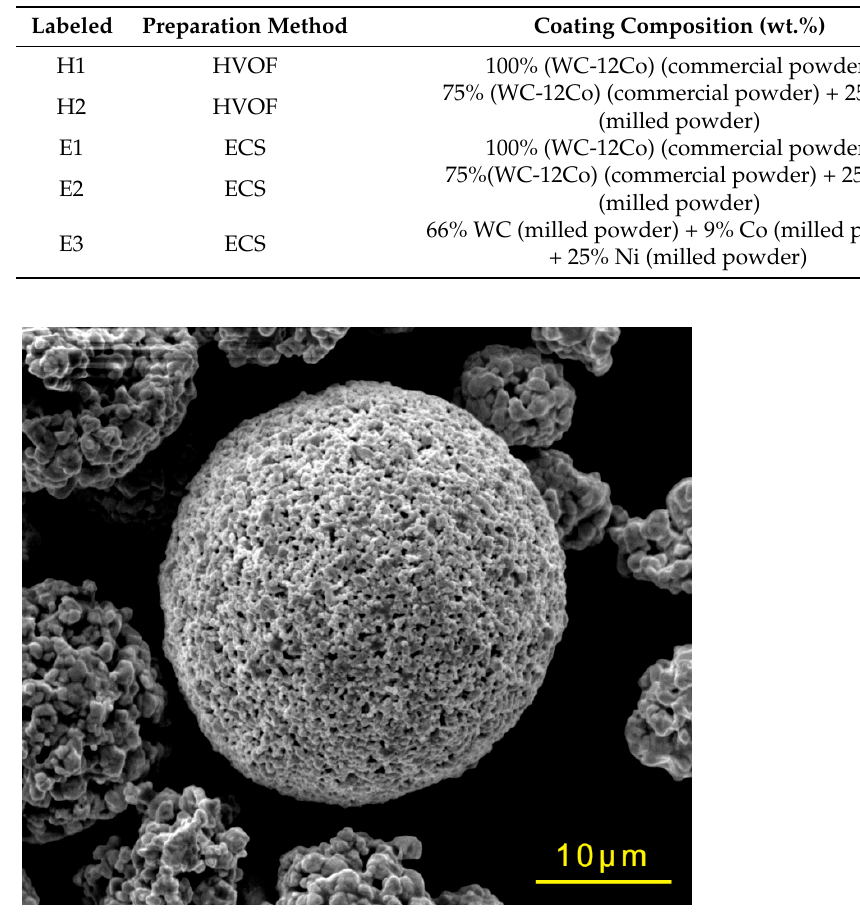
Table 2. Spraying parameters of HVOF. Spraying Parameters